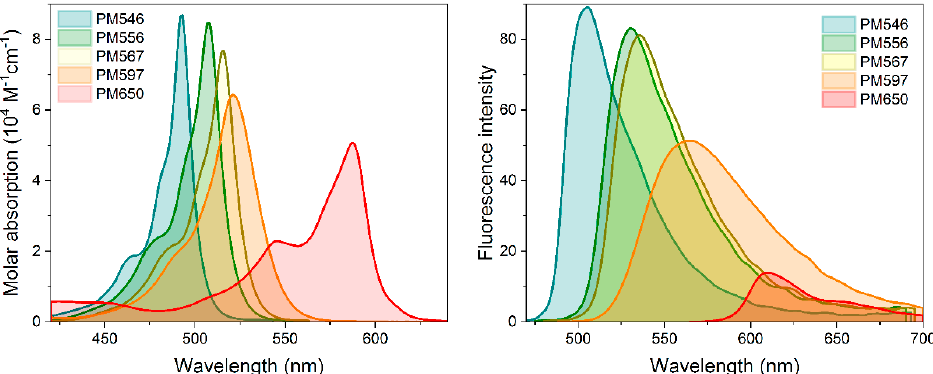
Figure 1. Absorption (scaled by the molar absorption) and steady-state fluorescence (scaled by the fluorescence efficiency) spectra of the commercial BODIPYs in diluted solutions (2 μ M) of acetonitrile.